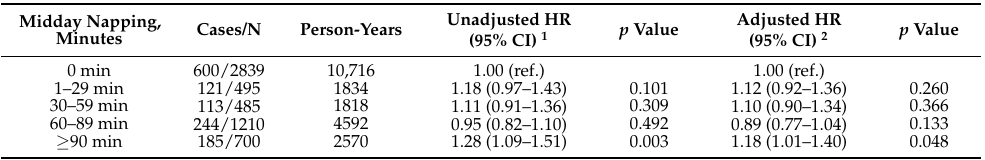
Table 2. Hypertension risk between 2011–2015 follow-up across categories of midday napping at baseline.